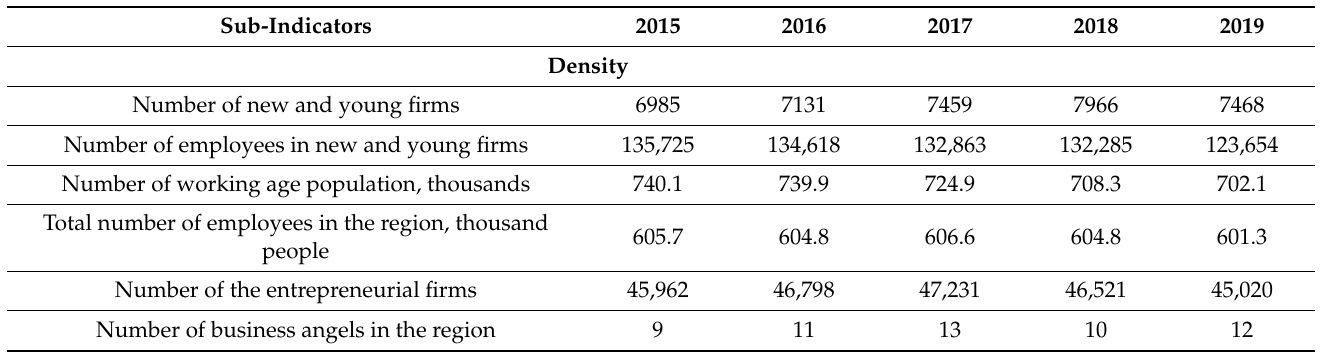
Table 5. Initial data for assessing the maturity of the Penza region entrepreneurial